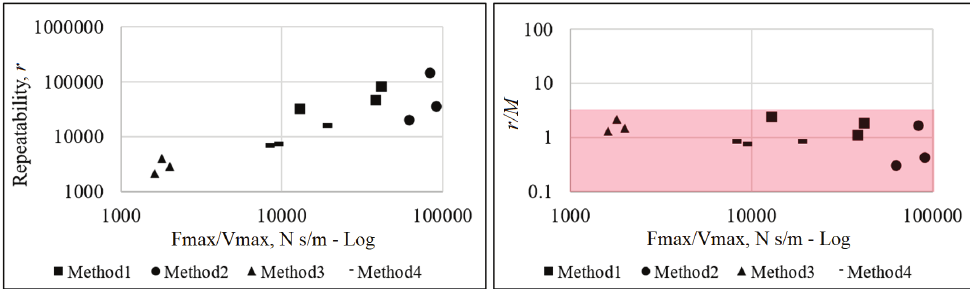
Figure 8. Repeatability and r / M of F max / V